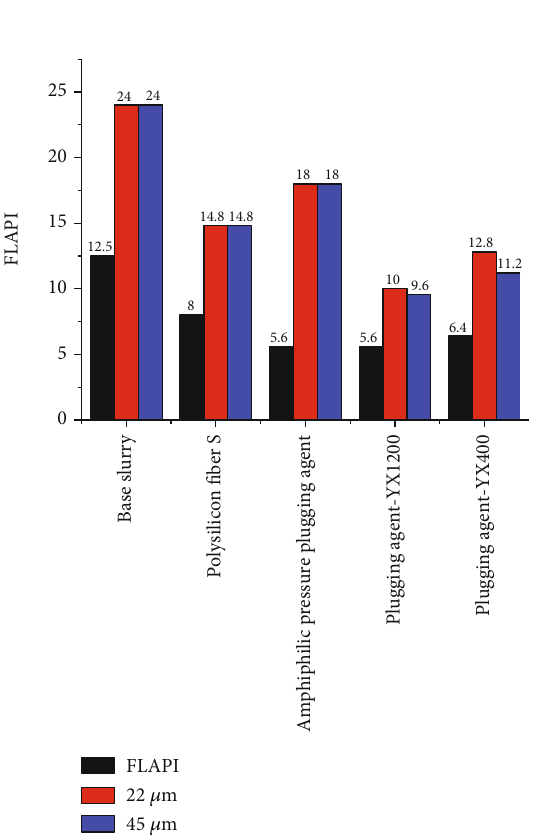
Figure 8: Comparison chart of API and microporous membrane fi lter loss after